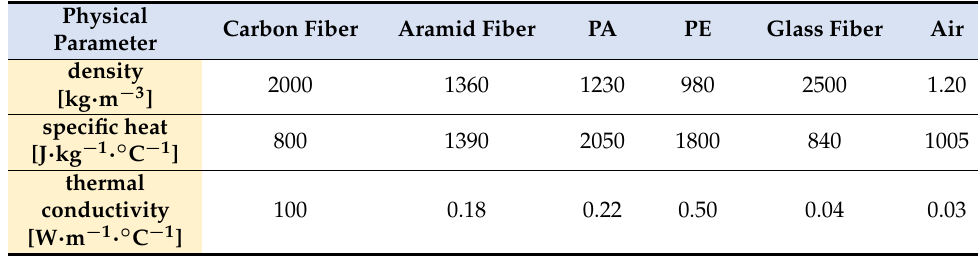
Table 2. Physical features of raw materials applied in simulations.